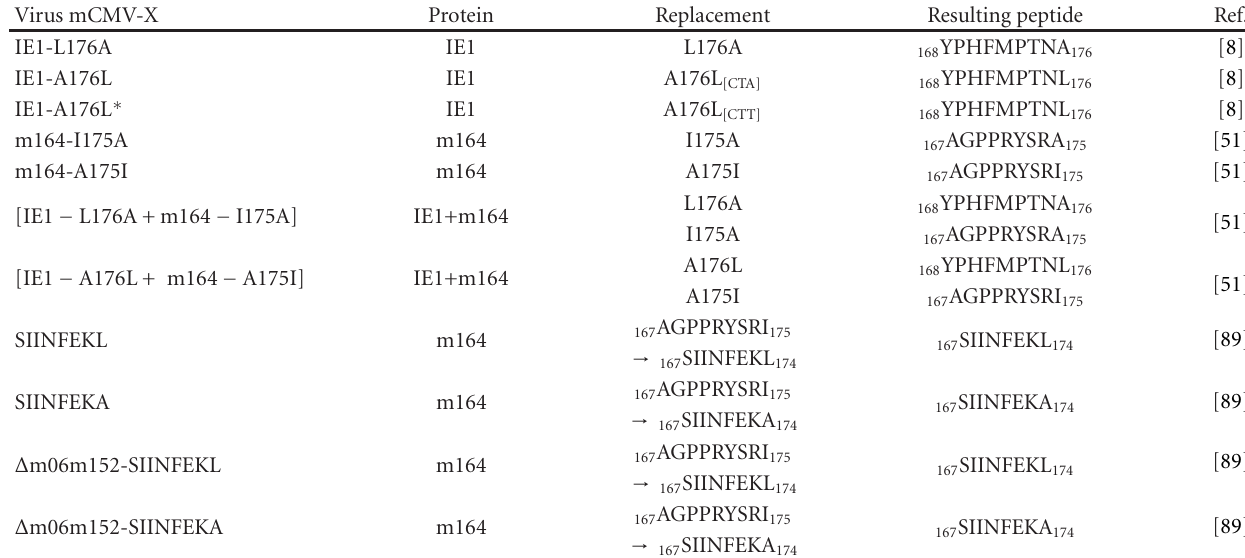
Table 1: Recombinant mCMVs with mutated CD8 T cell